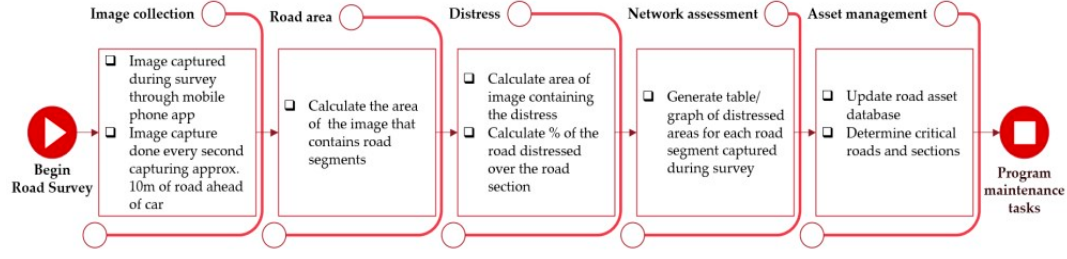
Figure 17. Pipeline for applying the model in real-world conditions for health monitoring.